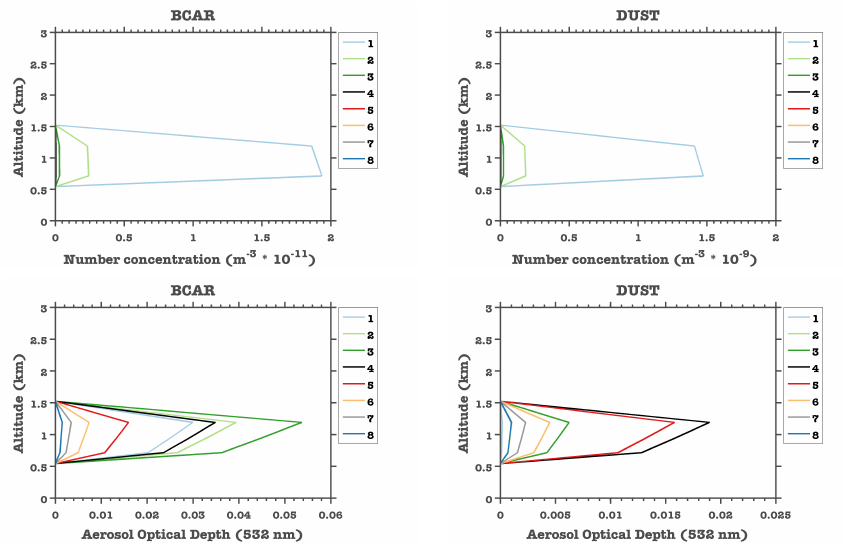
a function of size (radius) for 2 different wavelengths ( λ =532 , 1064 nm ).